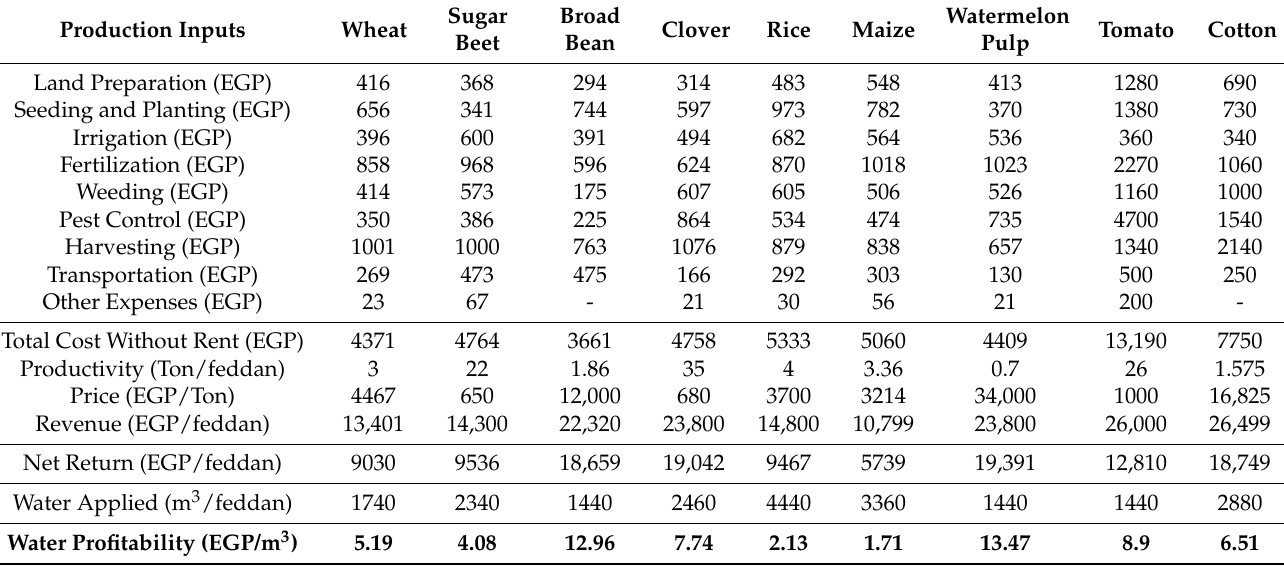
Table 3. Water Profitability Analysis for El-Beheira Governorate in 2020, source: field data collected from farmers and verified by